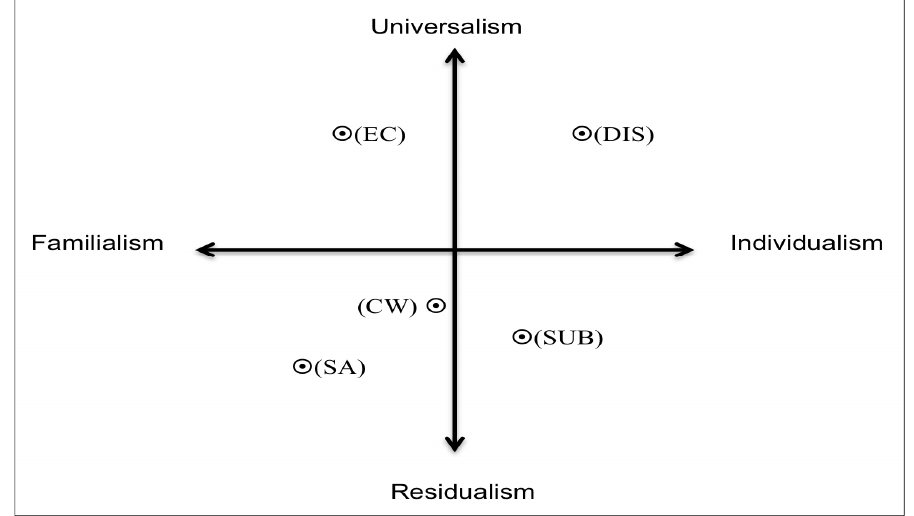
Figure 1. Positioning the family in relation to welfare state